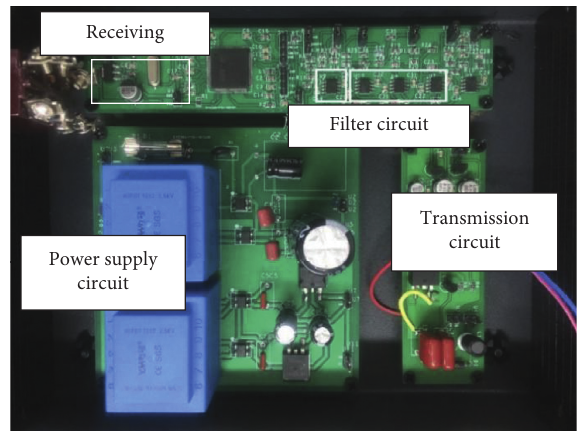
Figure 1: Digital multifunctional integrated circuit